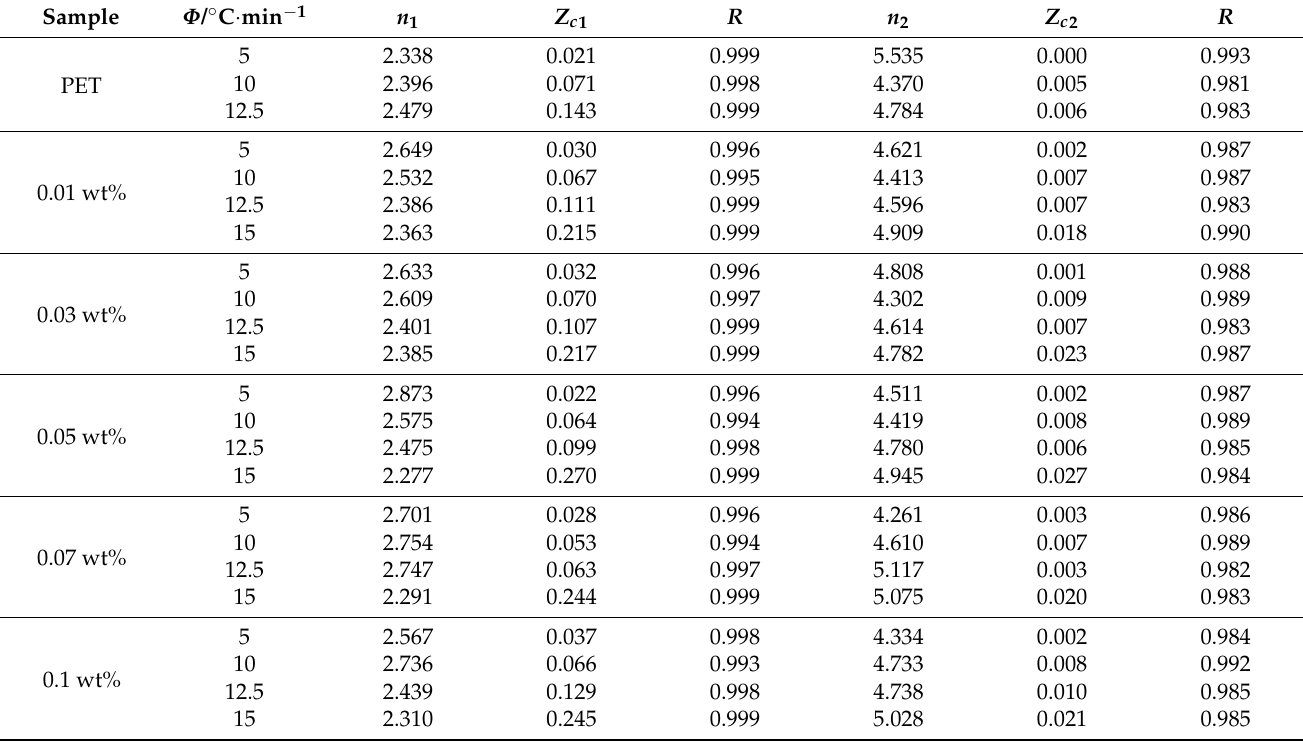
Table 3. Non-isothermal crystallization kinetics by Jeziorny